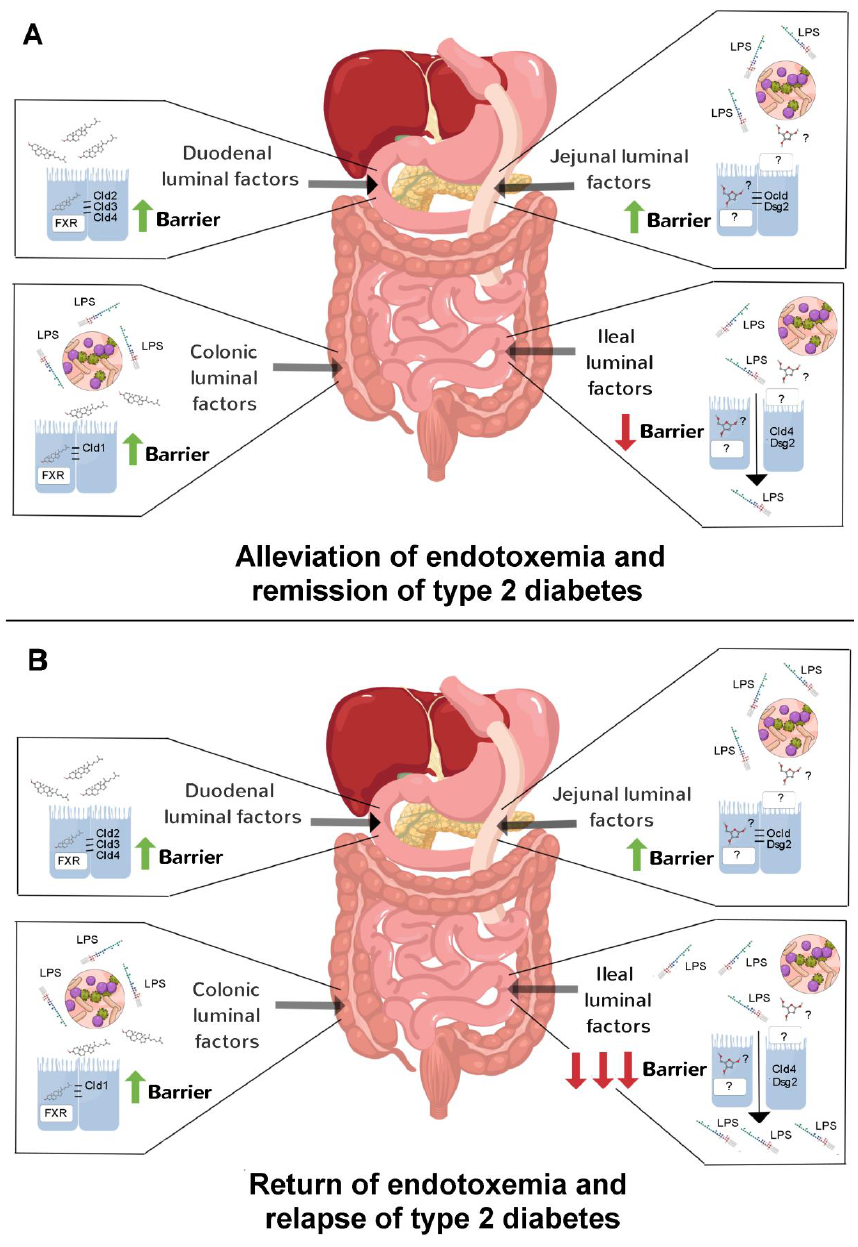
FIGURE 1: Postulated contribution of site-specific effects of RYGB on the gut barrier on glycemic control. (A) During diabetes remission after RYGB, the barrier-stabilising effects of jejunal and colonic content may out- weigh the barrier-destabilising effects of ileal content leading to alleviation of endotoxemia-induced insulin re- sistance. (B) During diabetes relapse, the barrier-destabilising effects of ileal content may outweigh the barri- er-stabilising effects of jejunal and colonic content leading to a return of endotoxemia-induced insulin re-